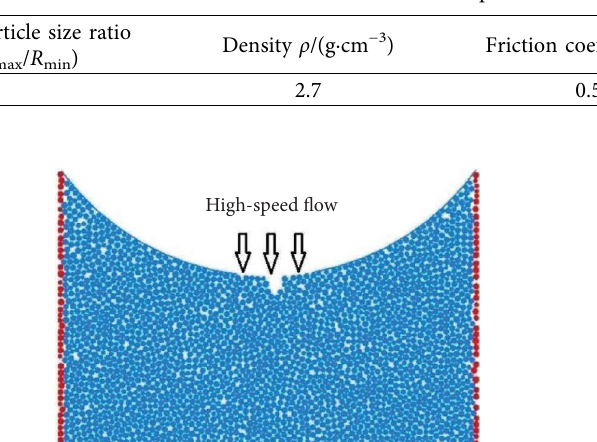
Figure 11: Particle fow model of surrounding rock. Table 2: Microparameters of surrounding rock model.